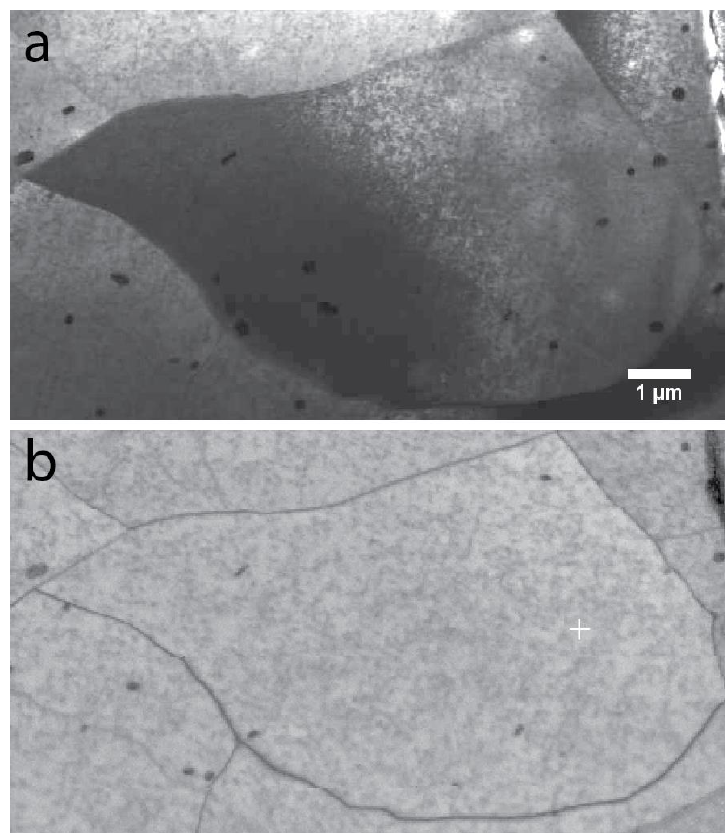
Figure 10. ( a ) Bright-field image of an AA2099 Al-Li-Cu alloy using the transmission mode of the SEM; ( b ) Band contrast (BC) image corresponding to the same area by transmission EBSD. The white cross locates the position of the reference EBSP used for pixel array selection for the reconstruction of the EBSD-DF images. The scalebar displayed on the STEM image in ( a ) applies to the BC image in ( b ).